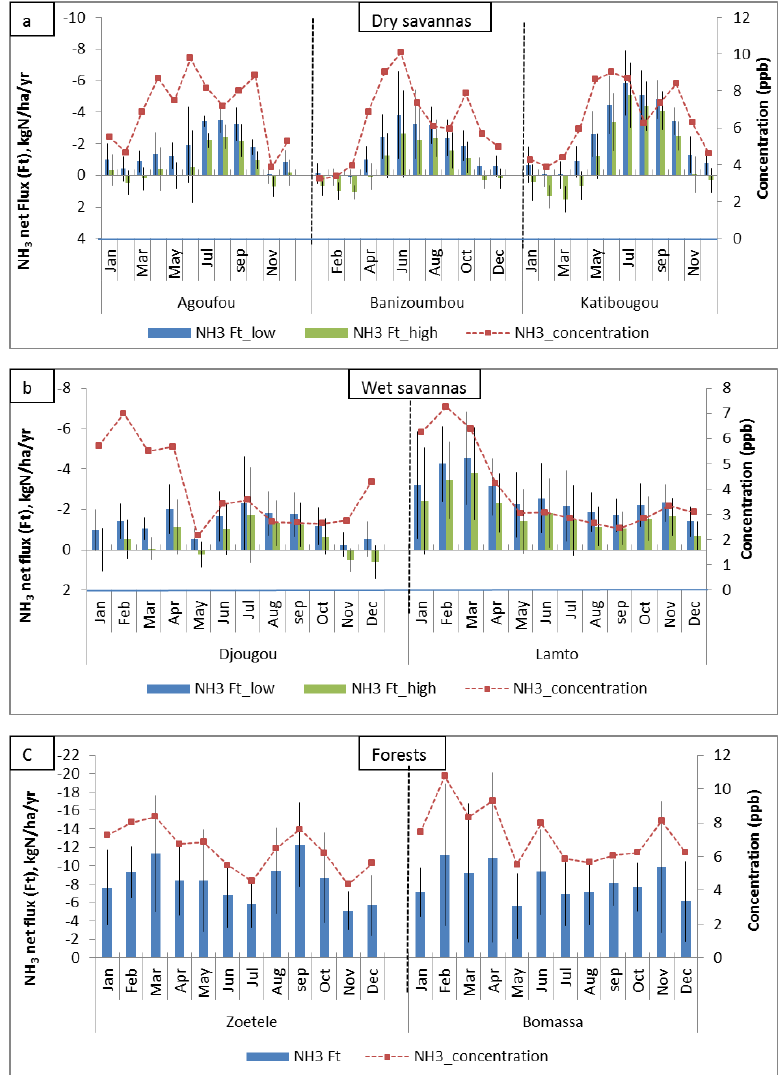
Fig. 7. Evolution of monthly bidirectional fluxes of NH 3 in kgNha − 1 yr − 1 (1998–2007) on the transect dry savannas (a) , wet savannas (b) and forests (c) associated with evolution of NH 3 concentrations (ppb). For the savannas, lower (Ft_low) and higher (Ft_high) scenarios of NH 3 net fluxes were